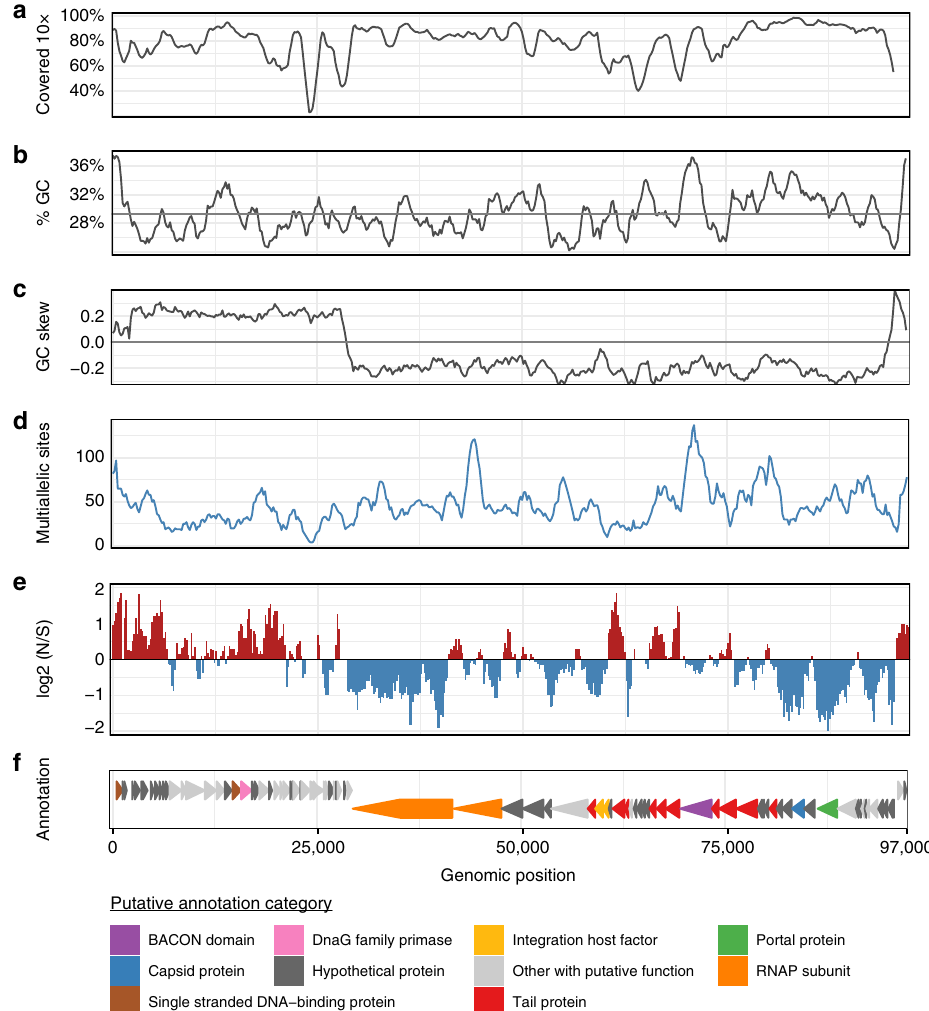
Fig. 4 The frequency and predicted effects of multiallelic sites vary across the p-crAssphage genome. a Fraction of samples from mothers covered at least 10x. All values are calculated with a sliding window of size 1500 bp with step size 200. b %GC content of the p-crAssphage reference genome. c GC skew of the p-crAssphage reference genome. d Total count of multiallelic sites (AF > 0.1) in the window. e Log base 2 ratio of nonsynonymous (N) to synonymous (S) multiallelic sites (AF > 0.1). f Annotation and selected predicted functions of genes in the reference